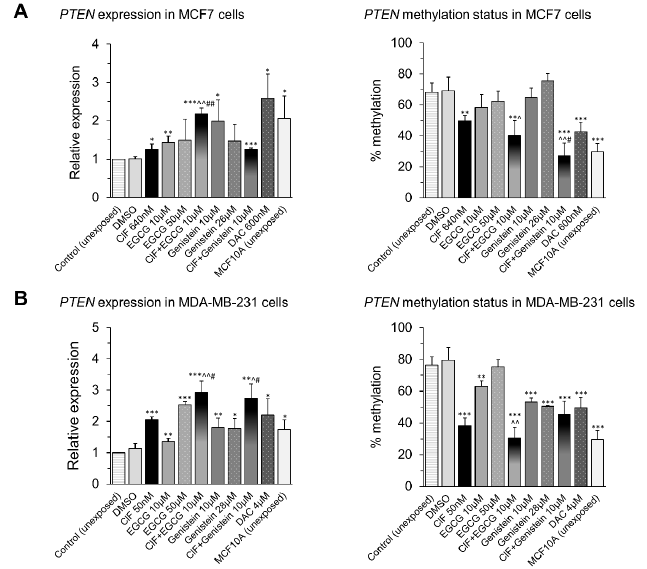
Figure 7. Effects of ClF (IC 50 ) and EGCG (10 µM) or genistein (10 µM) alone and in combination on expression (left panel) and methylation (right panel) of PTEN tumor suppressor gene in MCF7 ( A ) and MDA-MB-231 ( B ) cells. All results represent mean ± SD of three independent experiments. Exposure (ClF alone, EGCG alone, genistein alone, ClF + EGCG or ClF + Genistein) versus vehicle control, *** p < 0.001, ** p < 0.01, * p < 0.05. EGCG or genistein alone versus combinatorial exposure (ClF + EGCG or ClF + Genistein), ^^ p < 0.01, ^ p < 0.05. ClF alone versus combinatorial exposure (ClF + EGCG or ClF + Genistein), ## p < 0.01, # p < 0.05.